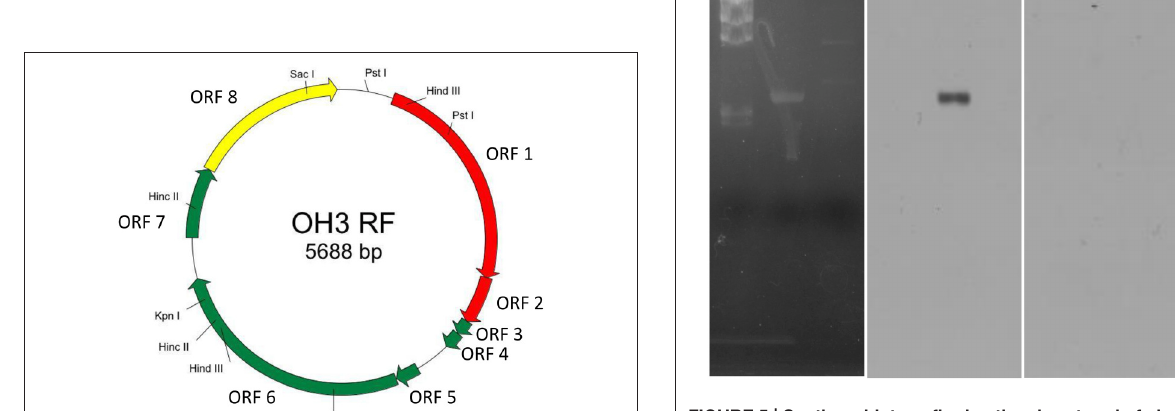
FIGURE 5 | Southern blot confirming the plus strand of phage ϕ OH3. Lanes: M, lambda - Hin d III marker; 1, ϕ OH3 ssDNA; 2, ϕ OH3 RF DNA. (A) RNA probe-1, which was transcribed by T7 RNA polymerase (antisense strand of ORF2). (B) RNA probe-2, which were transcribed by T3 RNA polymerase (sense strand of ORF2). Bands corresponding to ss DNA or RF DNA are indicted with arrows.